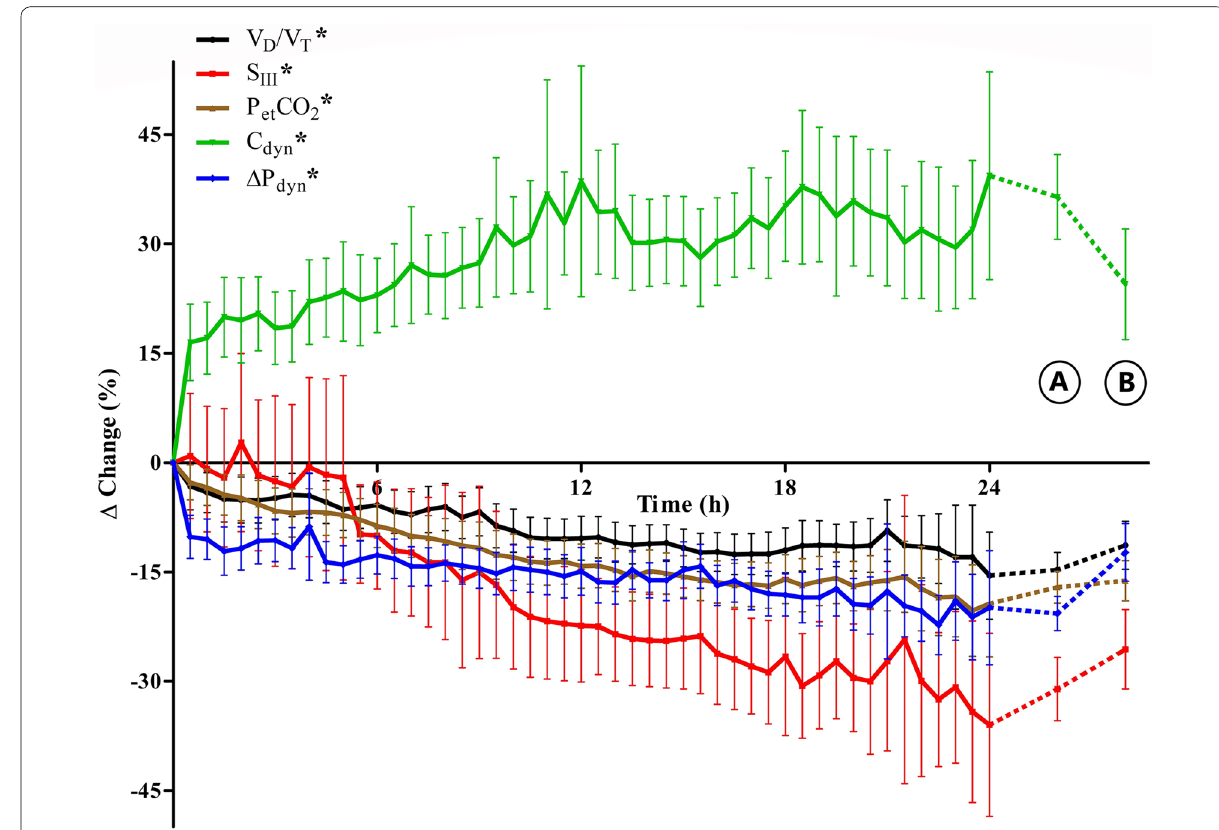
Fig. 2 Evolution of Δ V D / V T‑phy , ΔS III , Δ P et CO 2 and Δ C dyn in responder sessions for each parameter (all sessions), from 0 h (just before prone positioning) to 24 h of prone position; Ⓐ at sessions’ end (dotted line); Ⓑ 2 h after return in supine position (dotted line). * p < 0.05 (global time effect